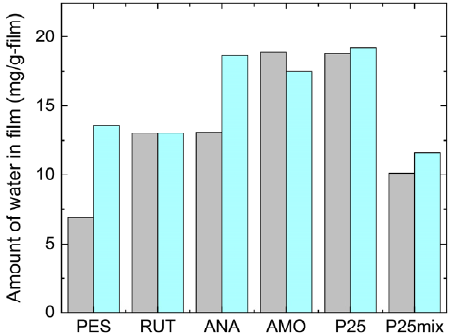
Figure 11. Water content in the reference (gray bars) and charged (light-blue bars) samples for the PES single film and PES films doped with 10 wt% TiO 2 nanoparticles at 40–50%RH.